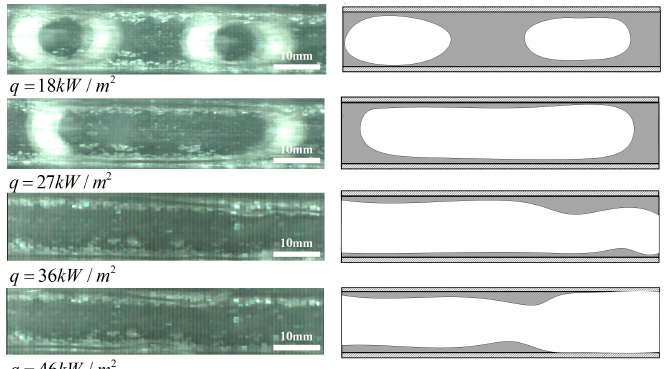
Figure 5. Two phase flow patterns of untreated surface microchannel under different heat fluxes for G = 1265 kg/(m 2 s), x in = 0.066.